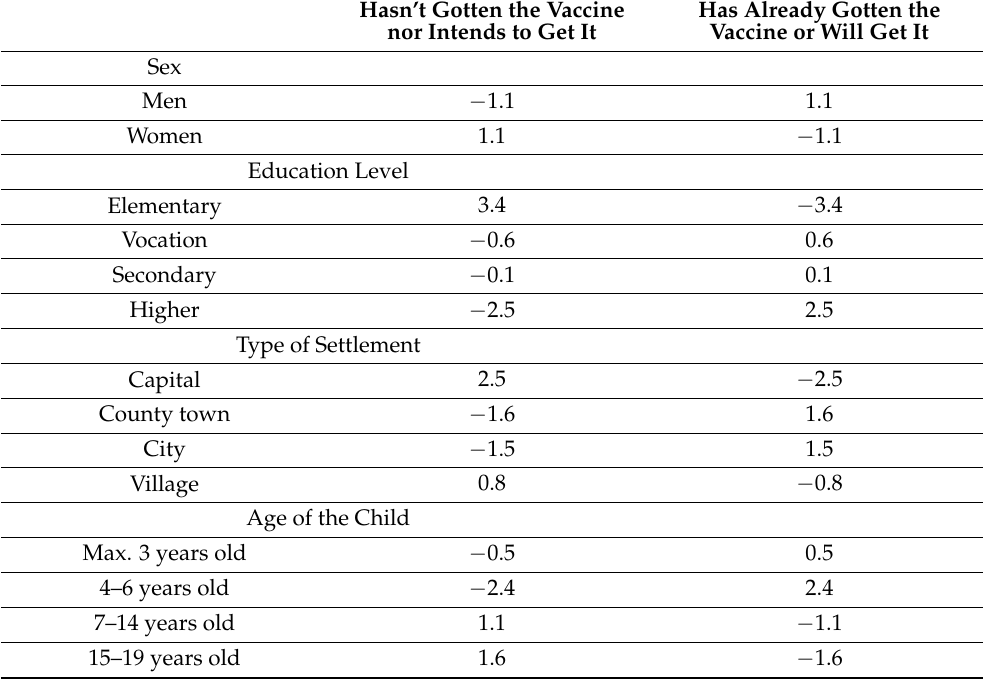
Table A9. Crosstabulation of the attitude towards the Piresian vaccine with different socio- demographic dimensions. Standardized Pearson residuals. (If the standardized Pearson residuals are larger than 2 in absolute value, we interpreted it that the cell is significantly different from the expected value of independence on a 0.05